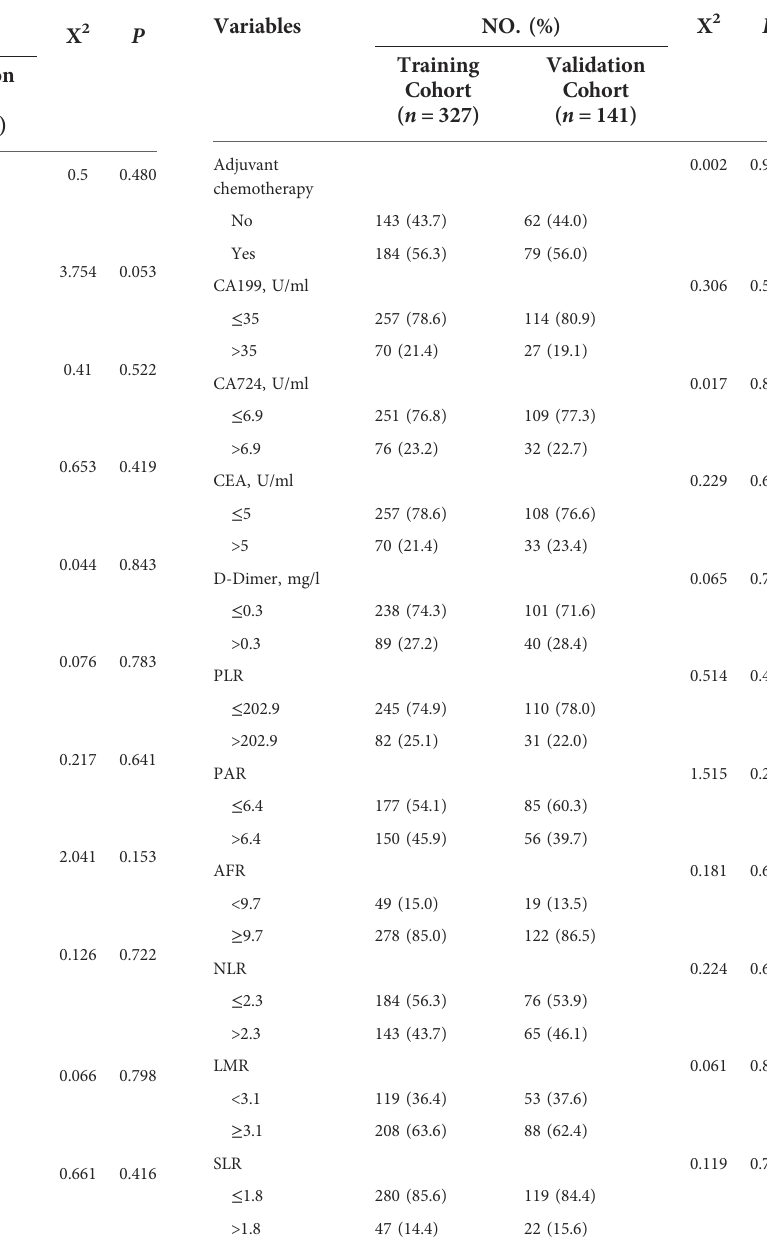
TABLE 1 Baseline characteristics of patients in the training and validation